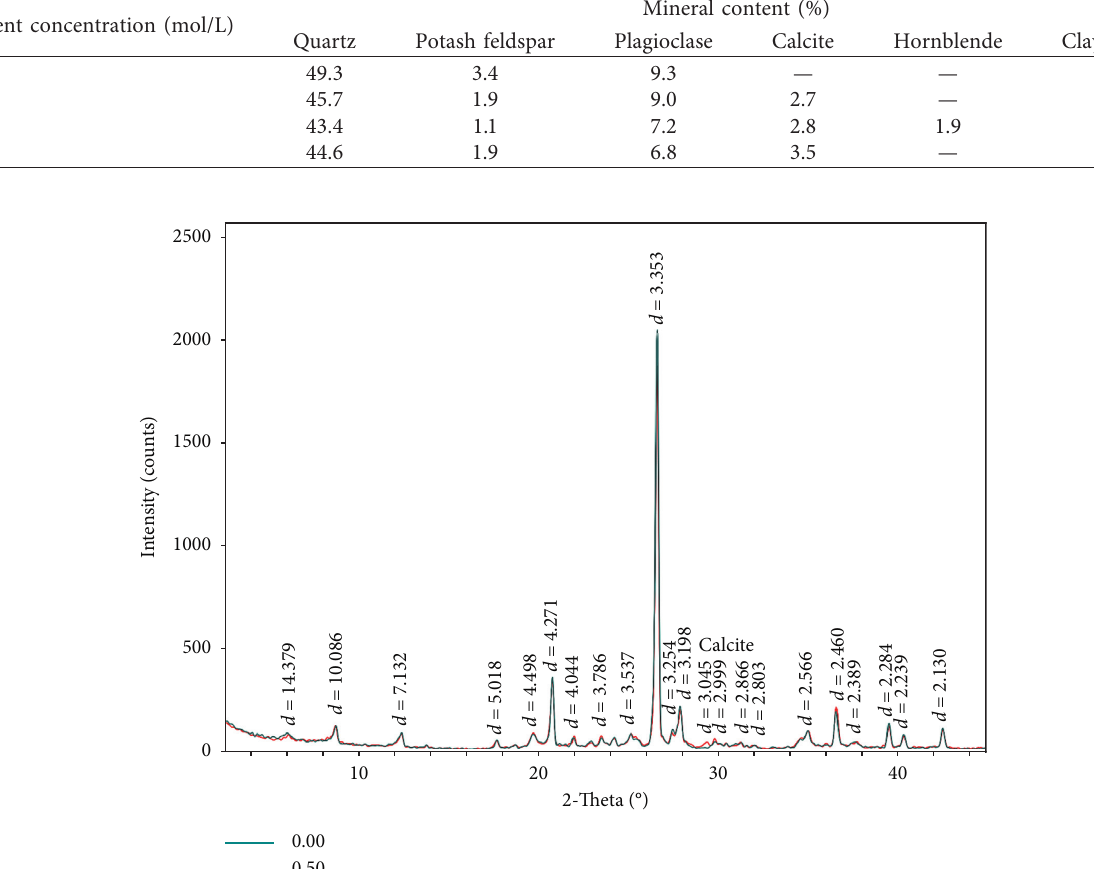
Figure 7: X-ray diffraction spectra for nonclay minerals in specimens infused with 0.00mol/L and 0.50mol/L nutrient